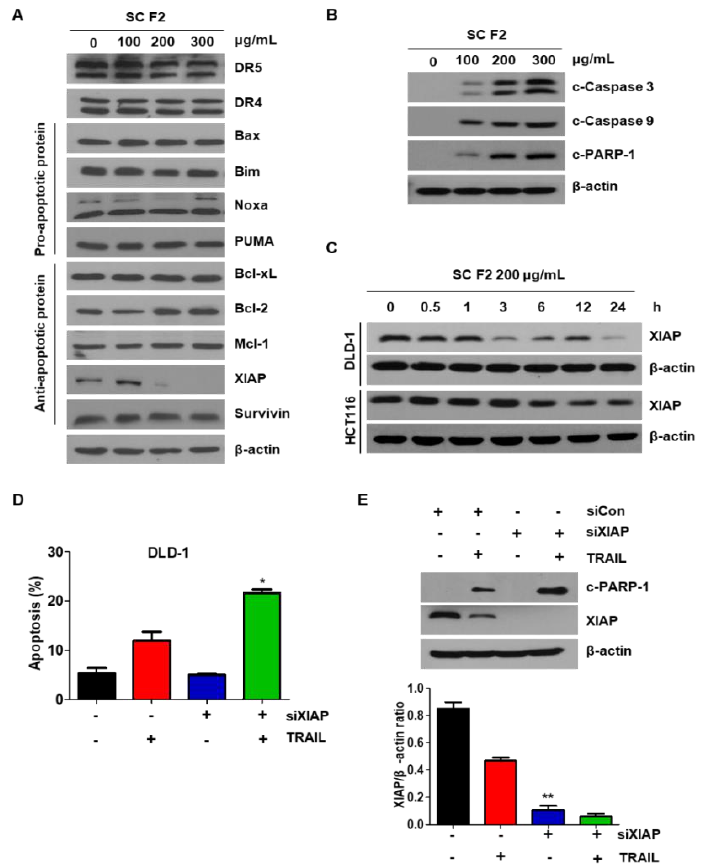
Figure 2. Suppression of XIAP by SC F2 sensitizes cells to TRAIL-mediated apoptosis. ( A ) DLD-1 cells were treated with the indicated concentrations of SC F2 for 20 h. Western blotting of death receptor (DR4, DR5), anti-apoptotic and pro-apoptotic protein. ( B ) DLD-1 cells were treated with indicated SC F2 doses for 20 h. Cell lysates were analyzed by Western blotting using anti-caspase 9, anti-caspase 3, and anti-cleaved PARP-1 antibodies. ( C ) DLD-1 and HCT116 cells were exposed to 200 µ g / mL of SC F2 for the indicated time intervals. Cell lysates were analyzed by Western blotting using an anti-XIAP antibody. ( D ) XIAP was silenced by XIAP siRNA in DLD-1 cells. The cells were then treated with TRAIL for 4 h followed by flow cytometry analysis. Error bars represent standard error of the mean (SEM) from three separate experiments. “*” represents a statistically significant di ff erence between TRAIL + siCon-treated and TRAIL + siXIAP-treated cells at p < 0.05. ( E ) XIAP was silenced by XIAP siRNA in DLD-1 cells. The cells were then treated with TRAIL for 4 h followed by Western blotting. ** p <